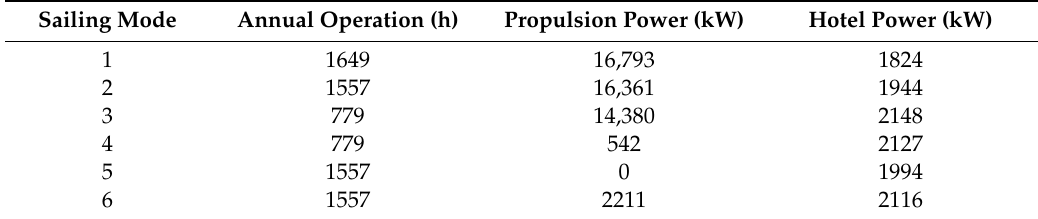
Table 4. Cruise ship: estimated propulsion and hotel power requirements in the various sailing modes.